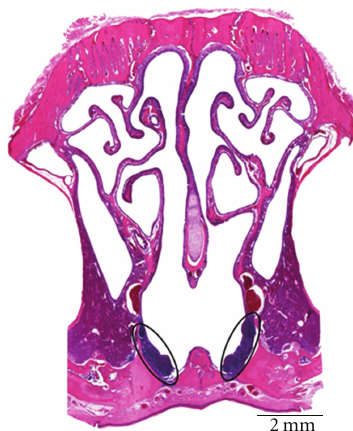
Figure 9: Histological cross section through the nose of a rat. The NALT at the bottom of the ventral nasal meatus is